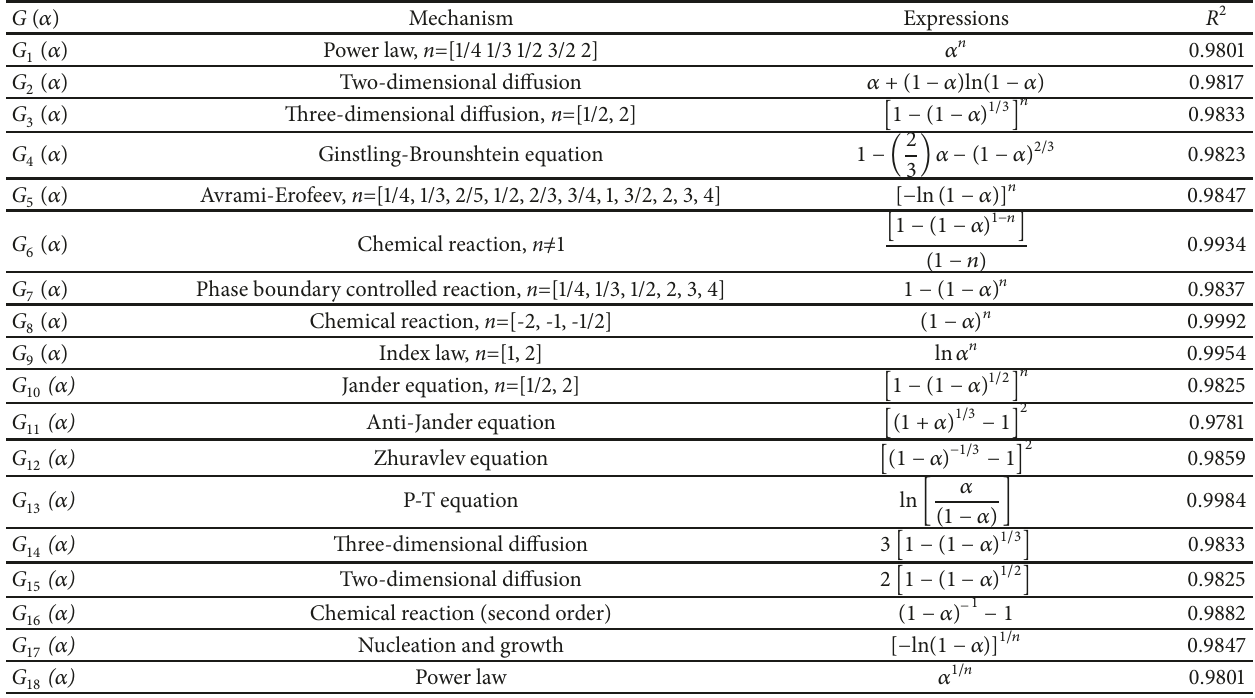
Table 3: Commonly used mechanism functions [22, 23].